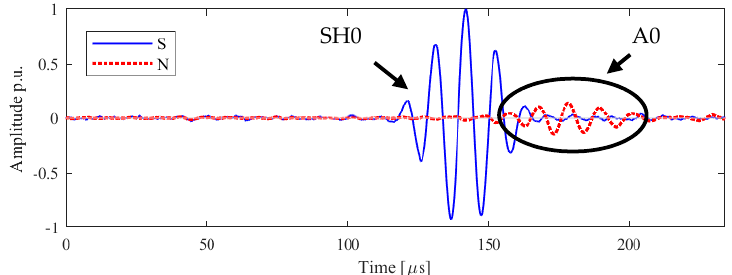
Figure 4. Laboratory experiments of the in-plane (blue), ‘S’, and out-of-plane, ‘N’, (red) velocities along the line orthogonal to the axis of vibration, for Configuration A. Normalized data are shown: modes are identified and labelled accordingly.